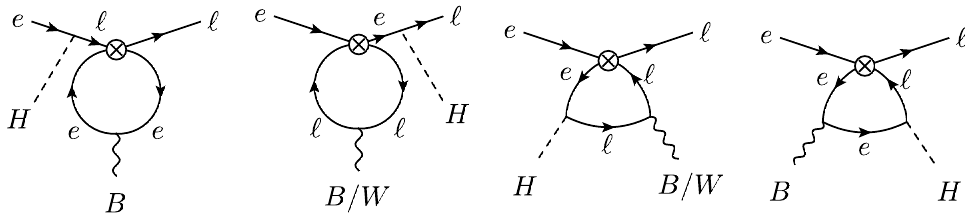
Figure 2. Feynman diagrams generating dipole matrix elements in the EFT. The crossed circle denotes an insertion of the four-lepton operators found from integrating out the second Higgs doublet Φ at